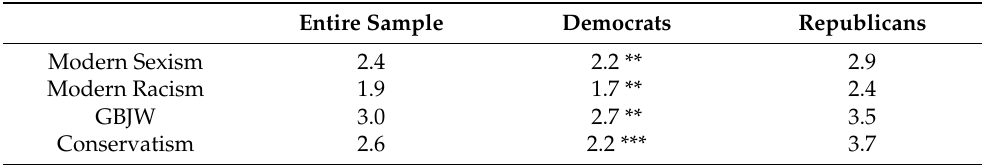
Table 6. Mean Scores on Modern Sexism, Modern Racism, GBJW, and Conservatism by Political